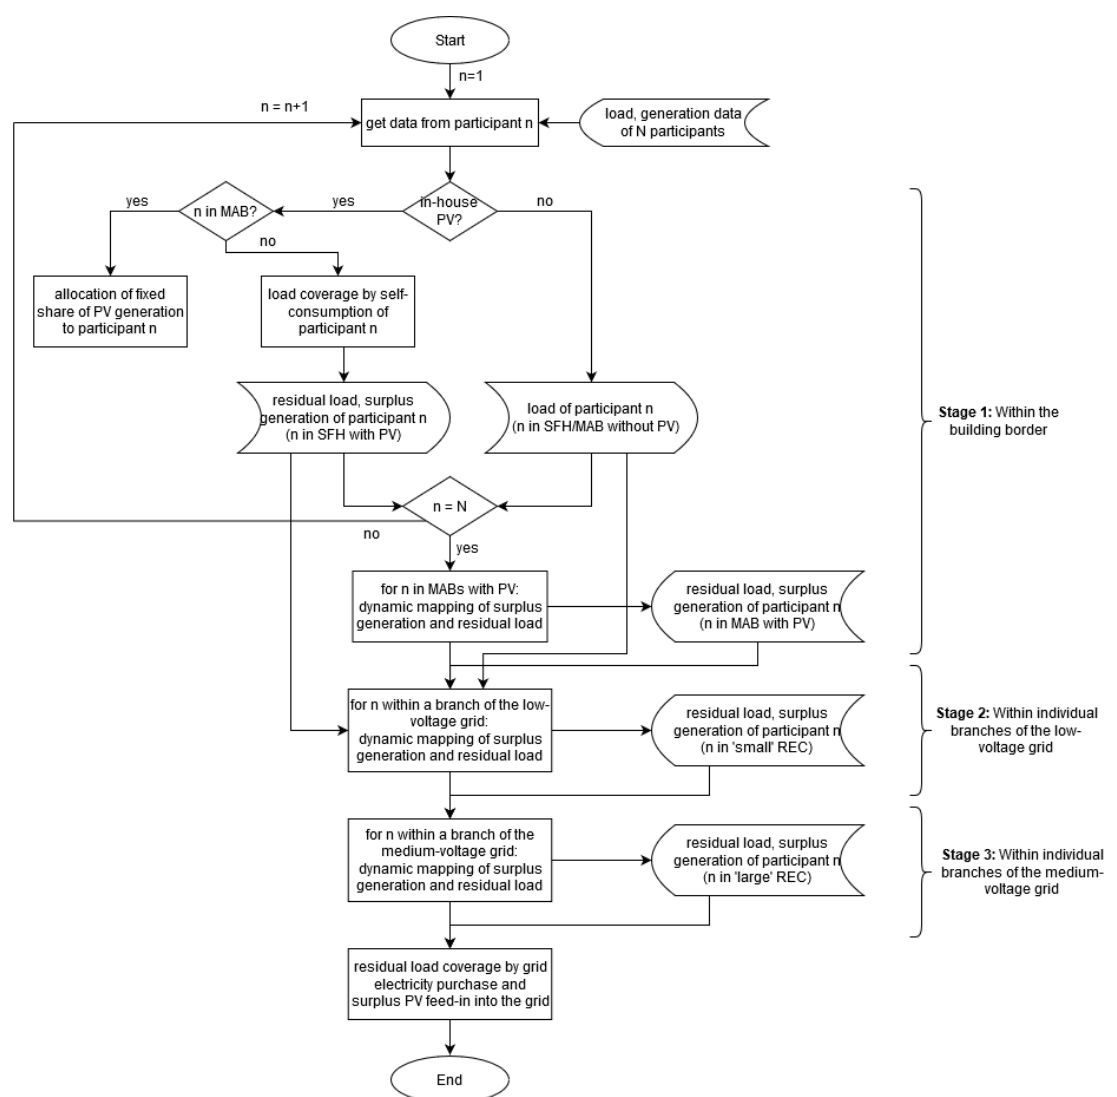
Figure 2. Flow chart of the three-stage simulation model concerning electricity trade within the borders of individual buildings, within ’small RECs’ (participants within a branch of the low-voltage grid) and finally within the ’large REC’ (participants within a branch of the medium-voltage